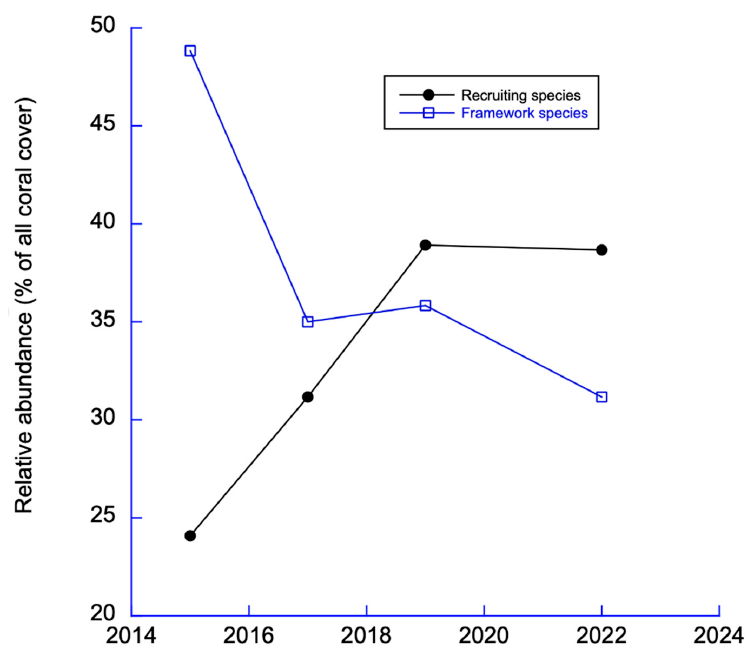
Figure 13. Relative abundances for juvenile ( A ) and adult ( B ) coral species. Juvenile (N, 20 spp.) and adult (N, 30 spp.) coral averages are for all sites and all years.